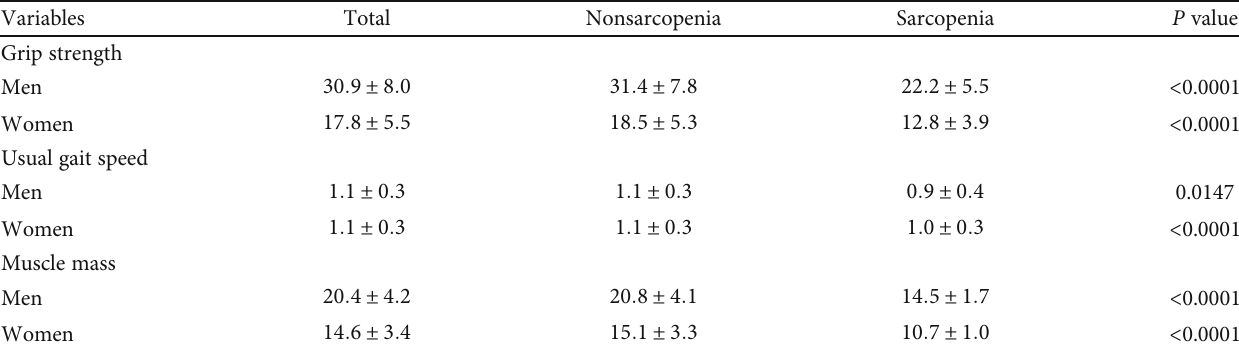
Table 2: Factors for diagnosis of